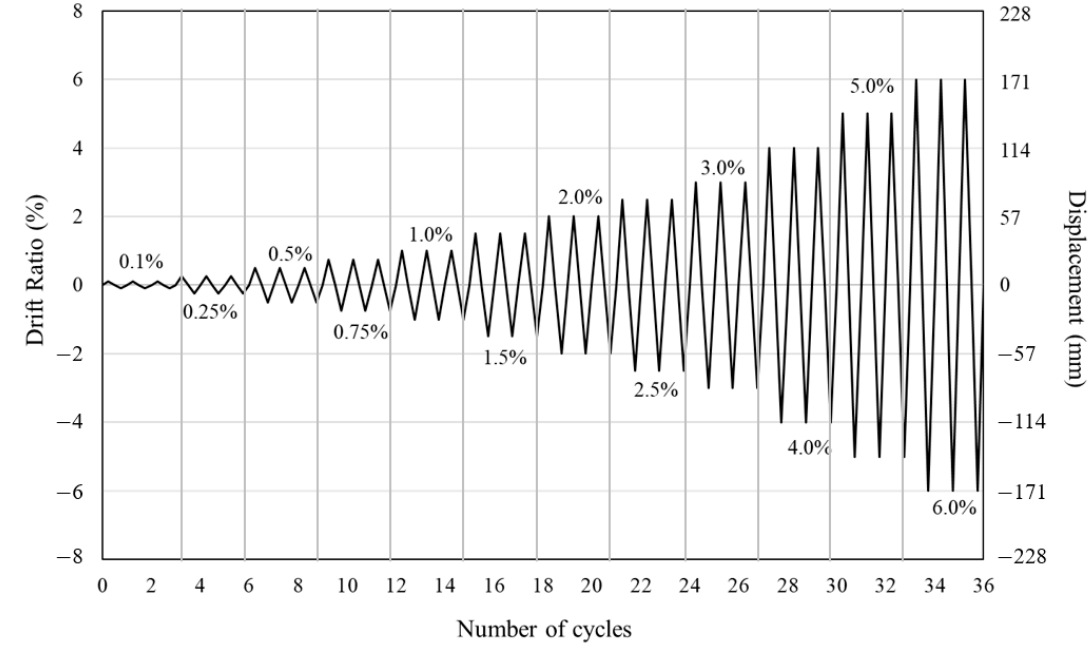
Figure 8. Loading protocol of the cyclic loading test.